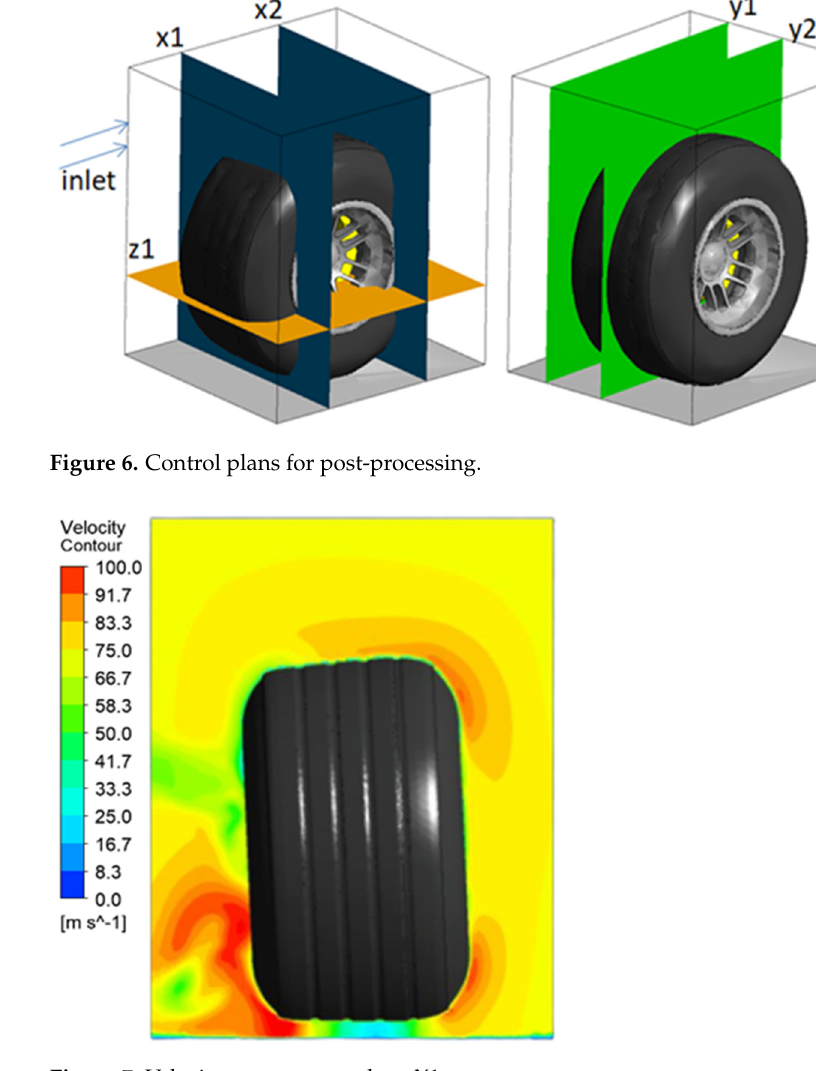
Figure 7. Velocity contours on plane X1.